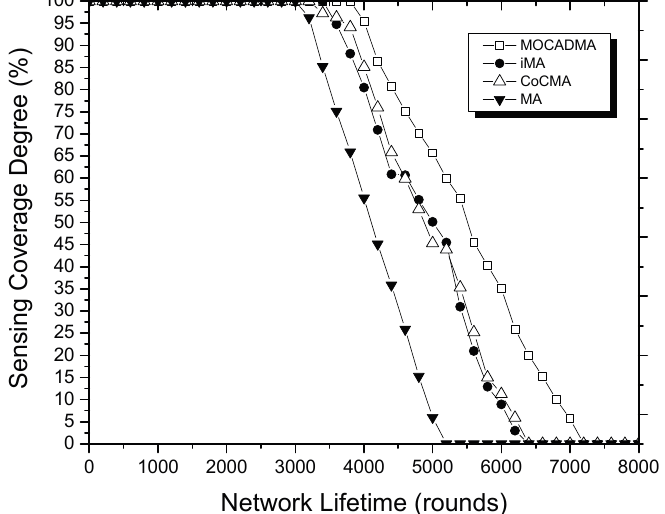
Figure 7. SCD versus network lifetime in